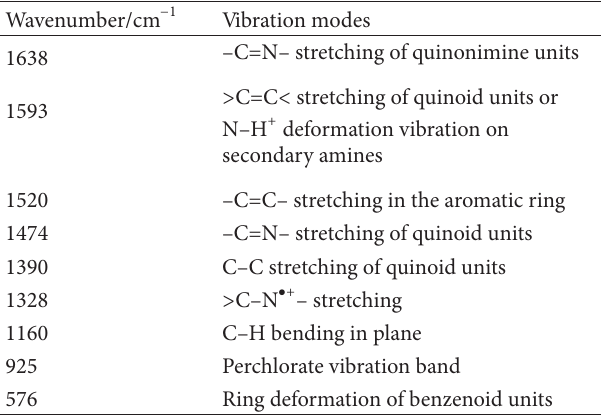
T 5: Vibrational bands in Raman spibrational bands in Raman [58]. spectrectra 4